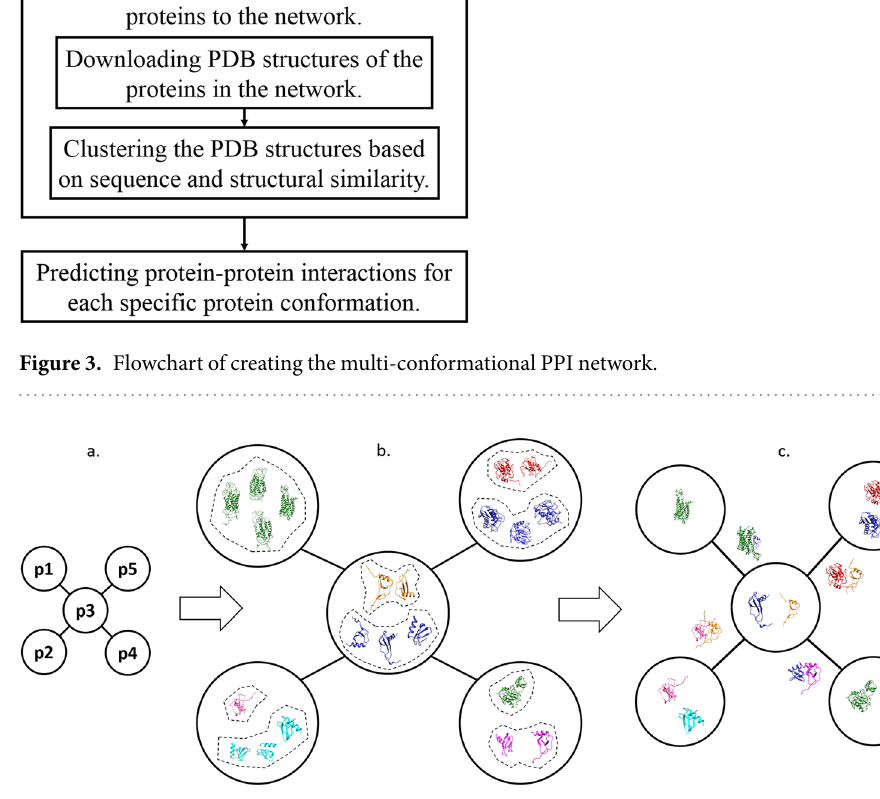
Figure 4. Graphical illustration of creating the multi-conformational PPI network. ( a ) Traditional PPI network. Each node represents a protein. ( b ) Available PDB structures for each protein. Similar conformations for each protein, indicated with the same colour, are clustered together. ( c ) For each cluster, just one PDB structure is selected as its representative. Two proteins may bind to each other by using specific